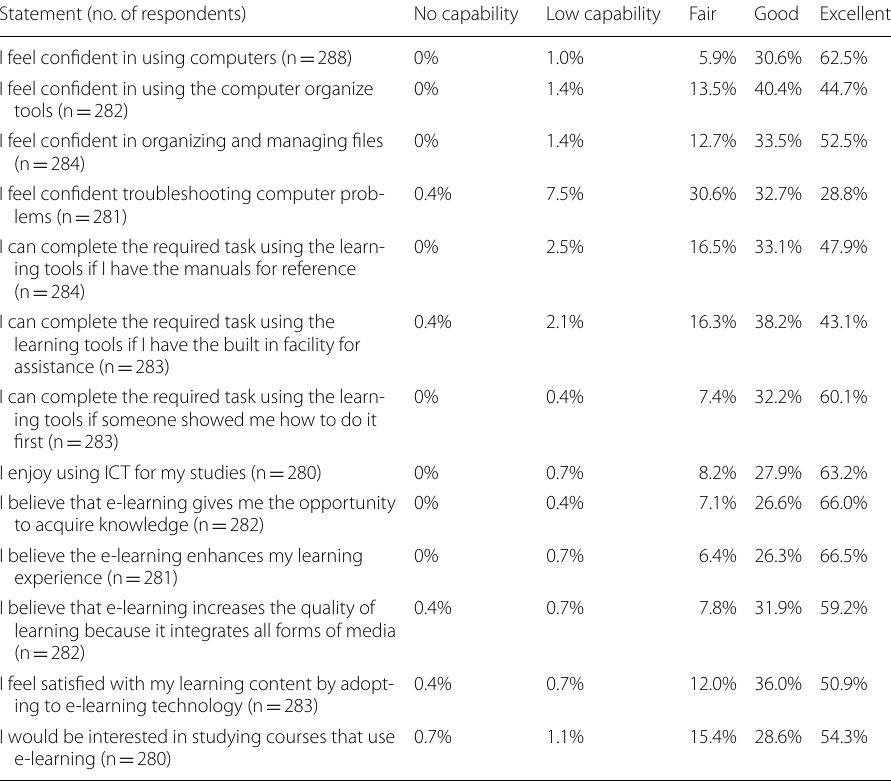
Table 5 Self-reported confidence of students in the use of ICT and e-learning Statement (no. of